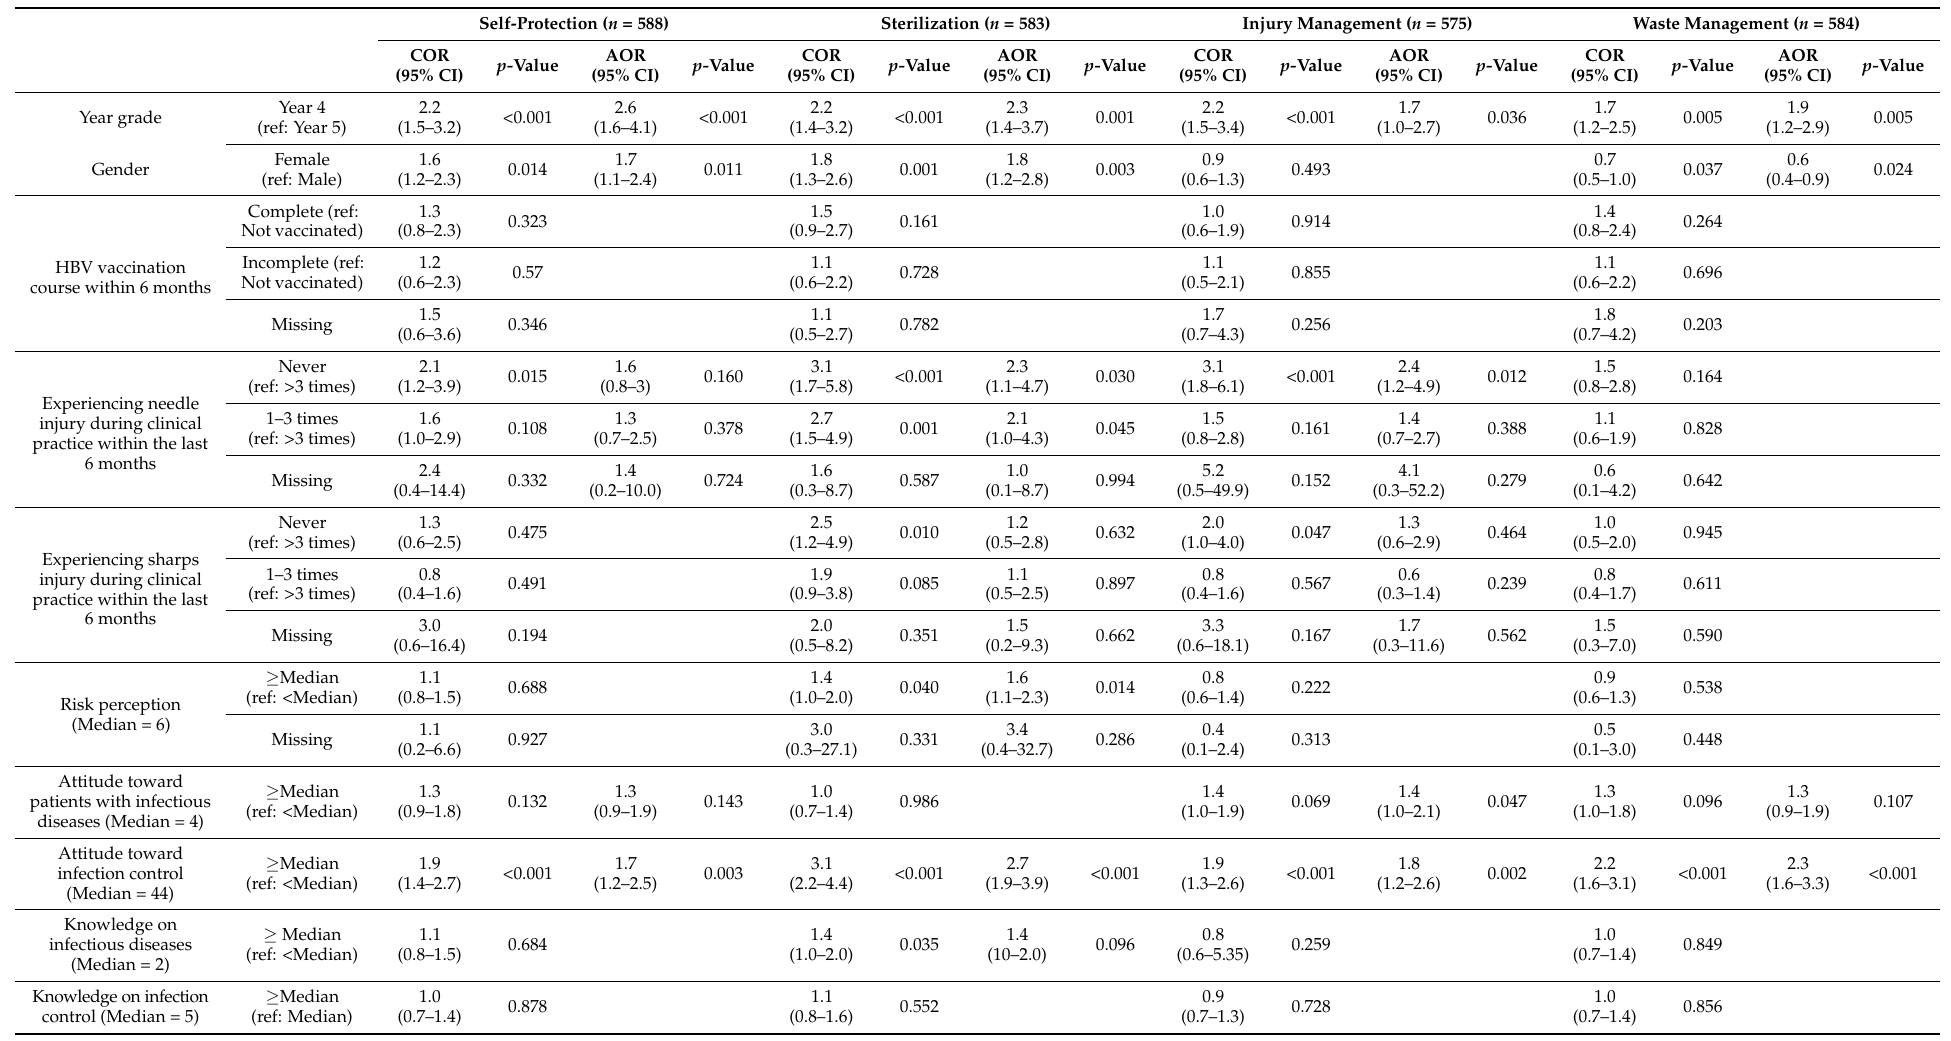
Table 4. Bivariate and multivariate logistic analyses for correlates of infection control practices among students in four Egyptian public dental